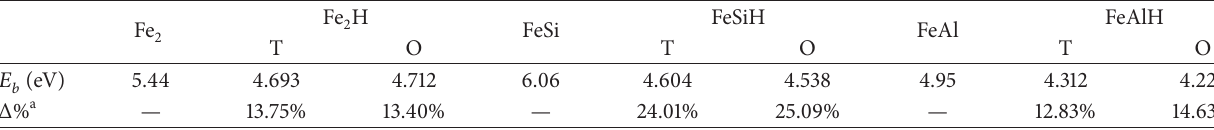
Table 4: Calculated binding energy of unit cells, eV.